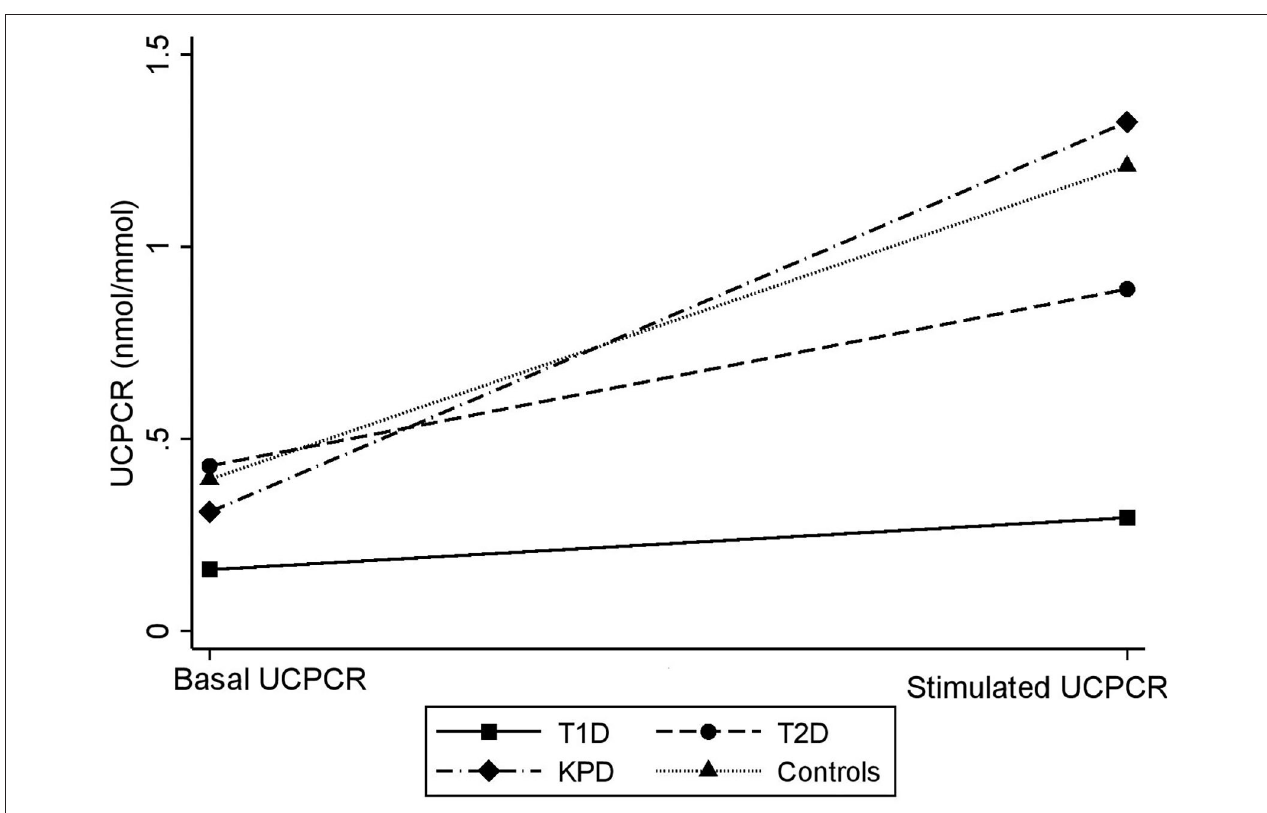
FIGURE 3 | Scatter showing difference in basal and stimulated UCPCR values across the different study groups. The gradient is lowest in participants with